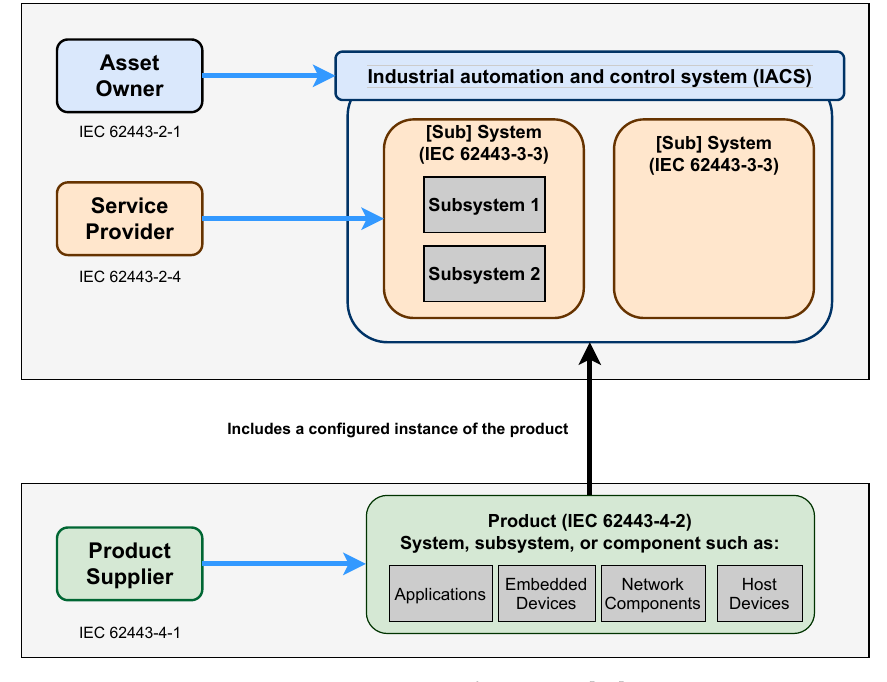
Figure 2. Overview of IEC 62443